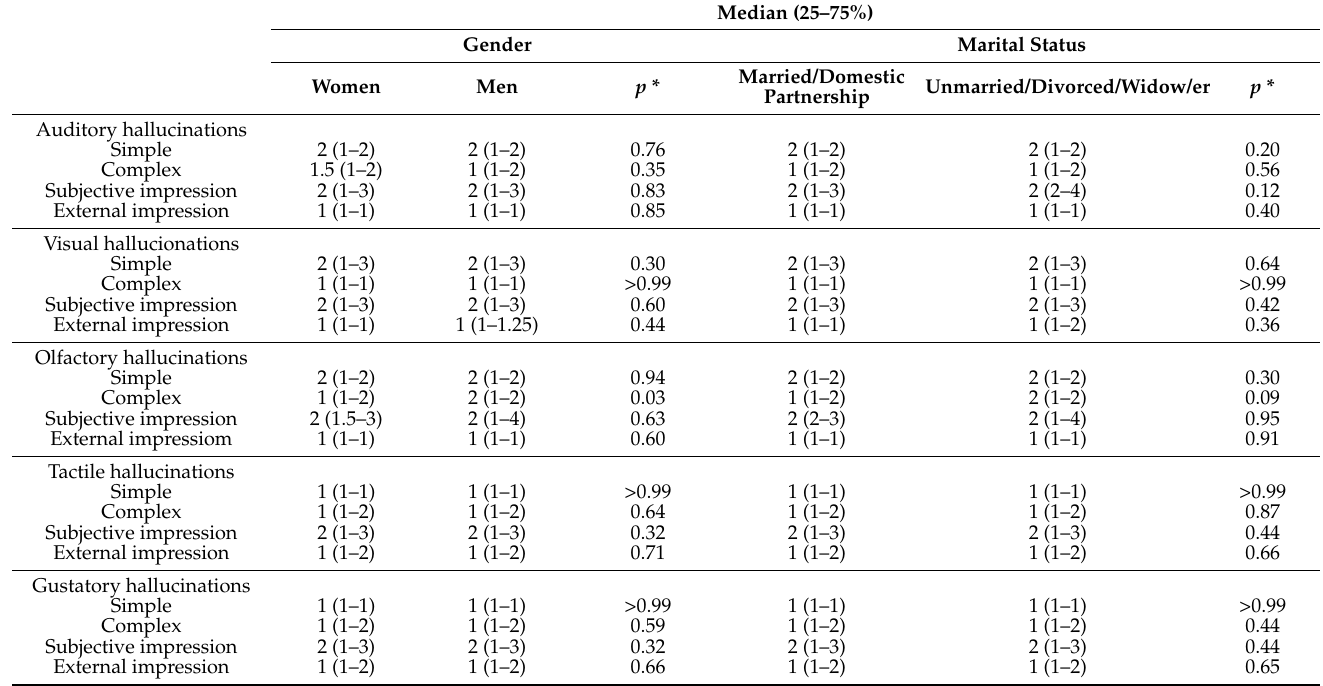
Table 4. Frequency of simple and complex hallucination, and according to the impression of subjective and external hallucinations in relation to gender and marital status.